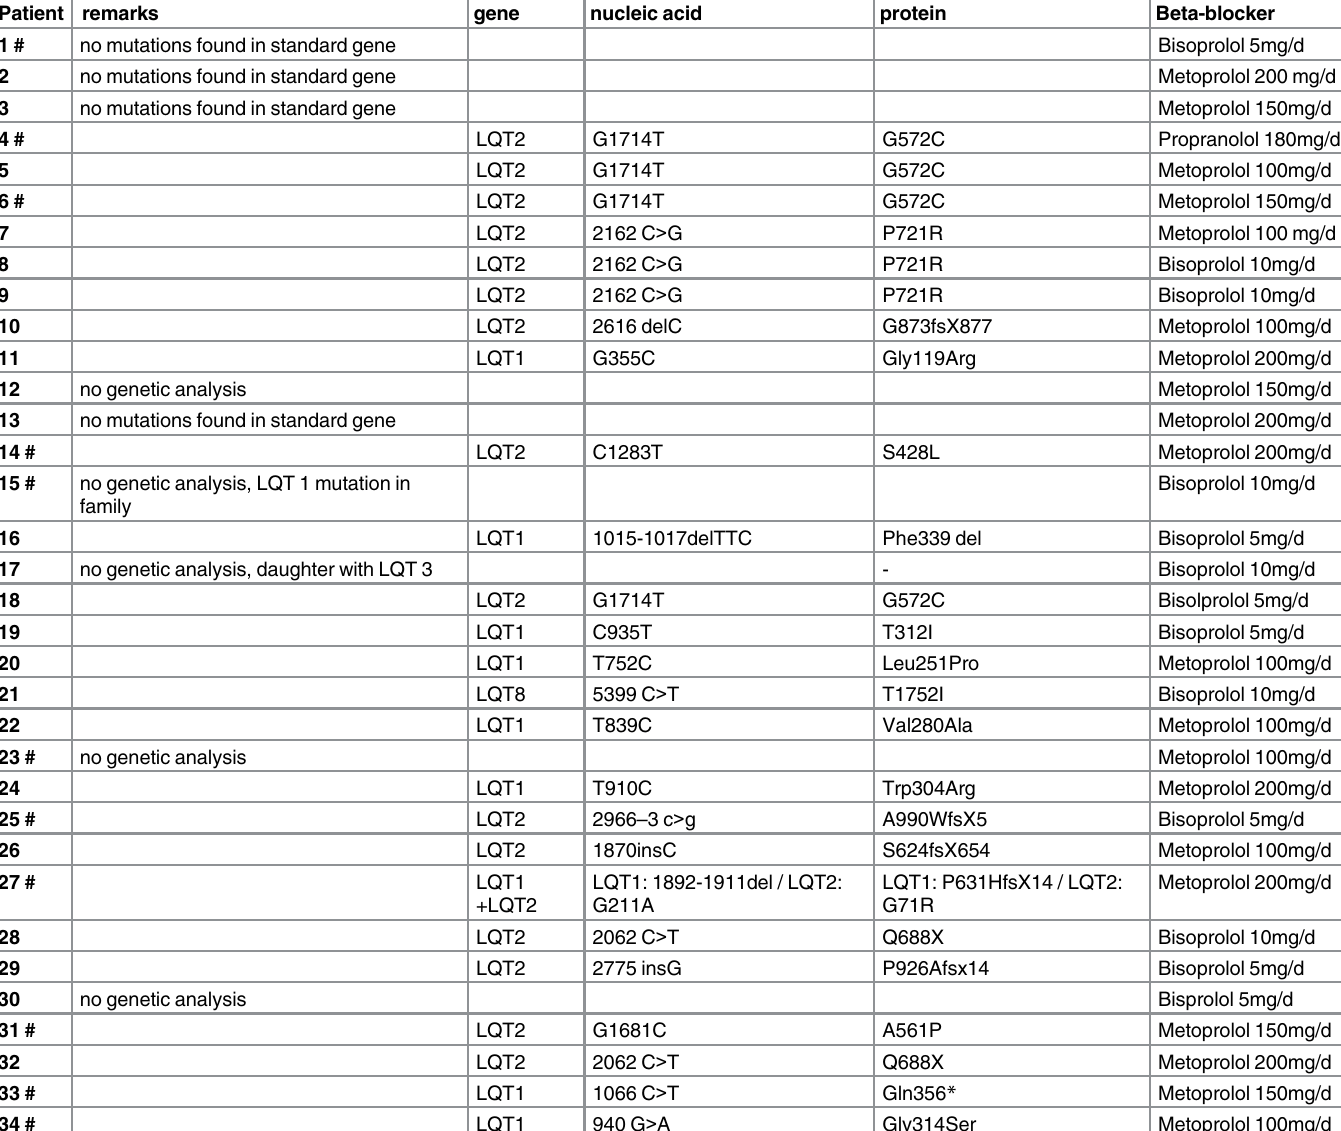
Table 2. Results of genetic analysis, beta-blocker dosage and clinical events of our study patients; # = patients with clinical